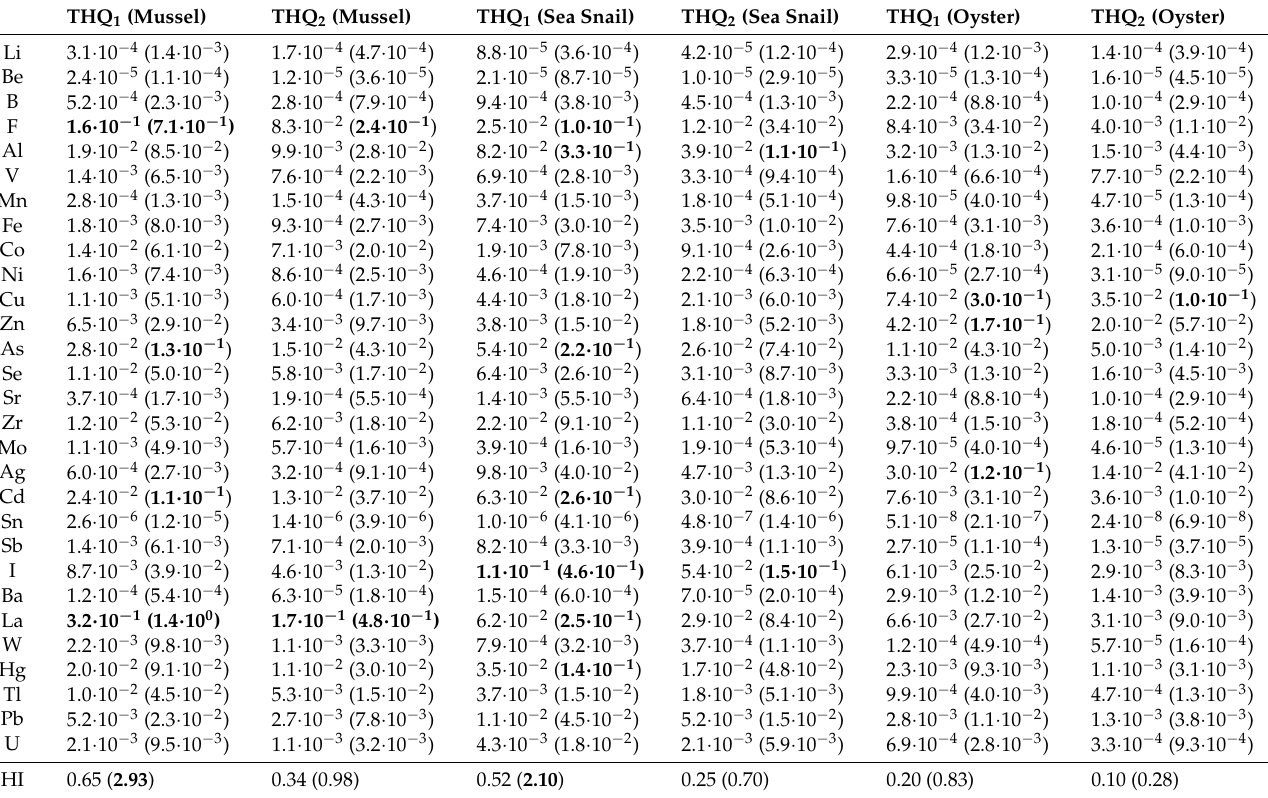
Table 4. Target hazard quotients (THQ) calculated for the pessimistic (THQ 1 ) and optimistic (THQ 2 ) scenarios using the oral reference doses [54]. HI: hazard index. THQ are presented as expected and (in parentheses) maximum values. The minimum values in all the cases are 0. Bold emphasis: THQ > 10 − 1 and HI >